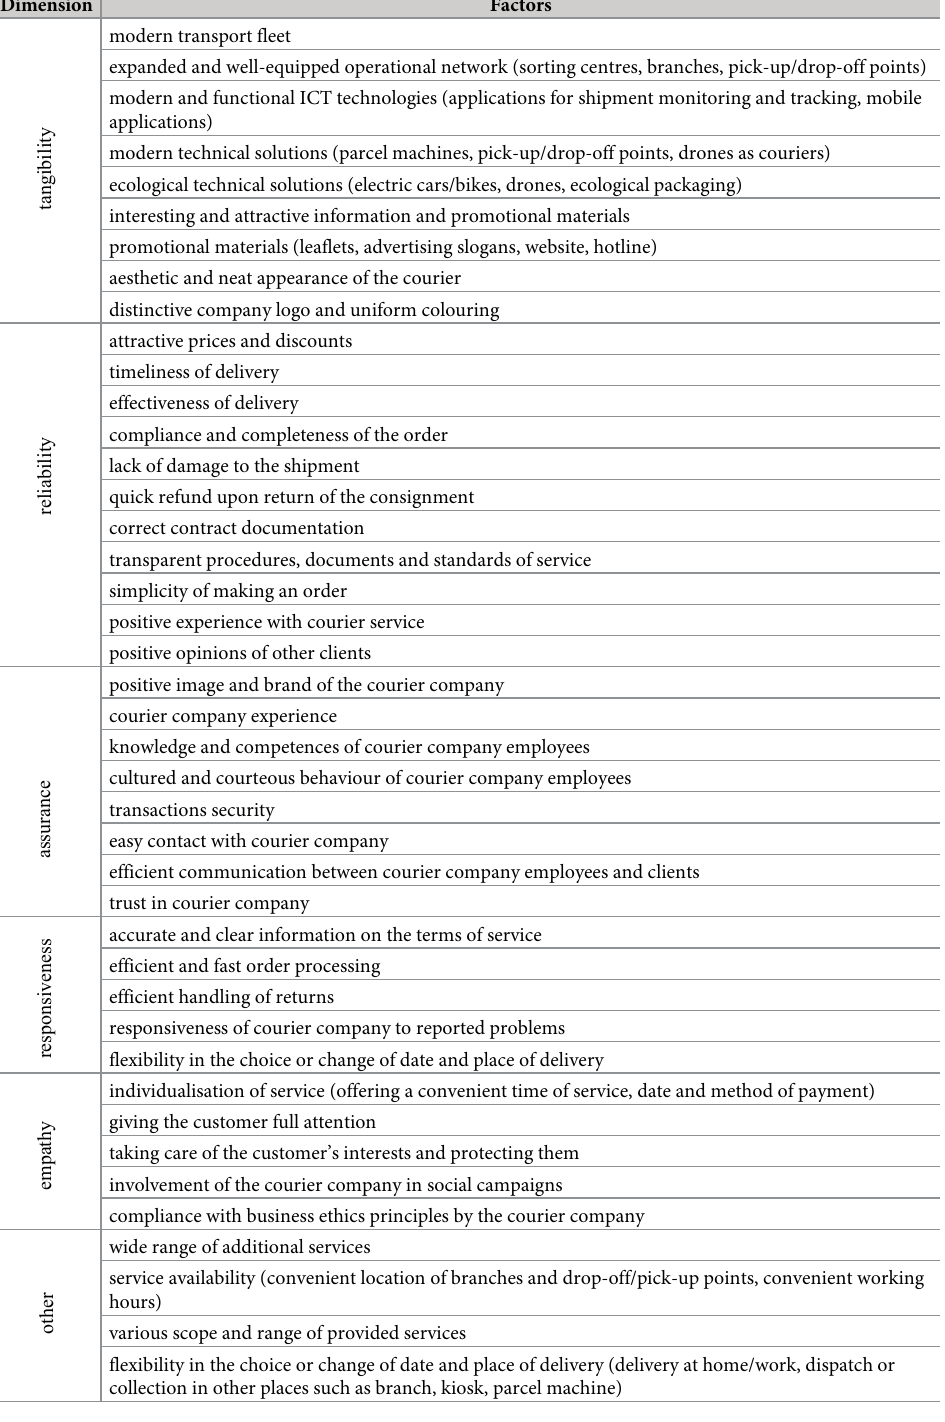
Table 1. List of factors determining the courier service